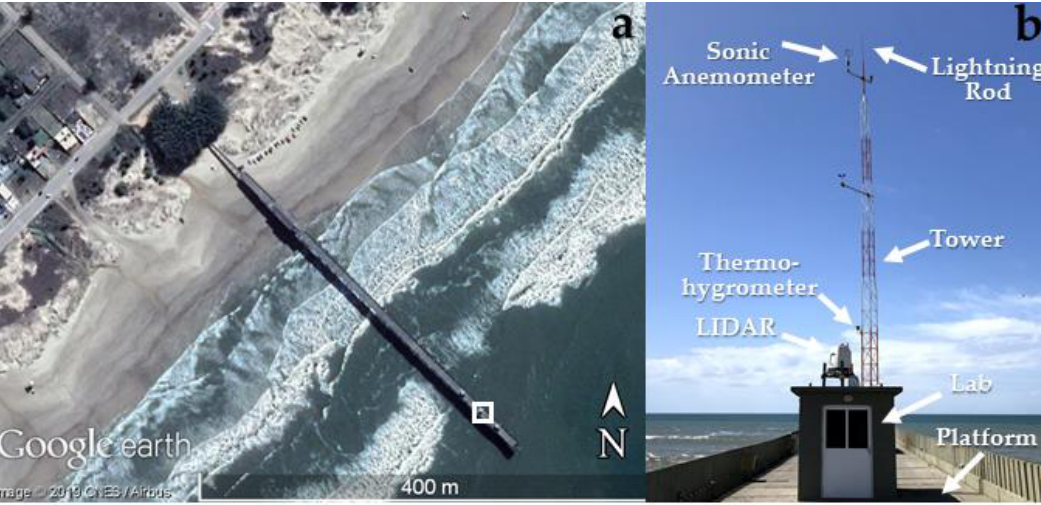
Figure 2. Study region. ( a ) A fishing platform (Entremares) that shows the position of BOOA on the platform (white square). BOOA is located at a latitude of −28.96300° and longitude of −49.38018°. ( b ) BOOA with the LIDAR, meteorological tower and its main sensors.